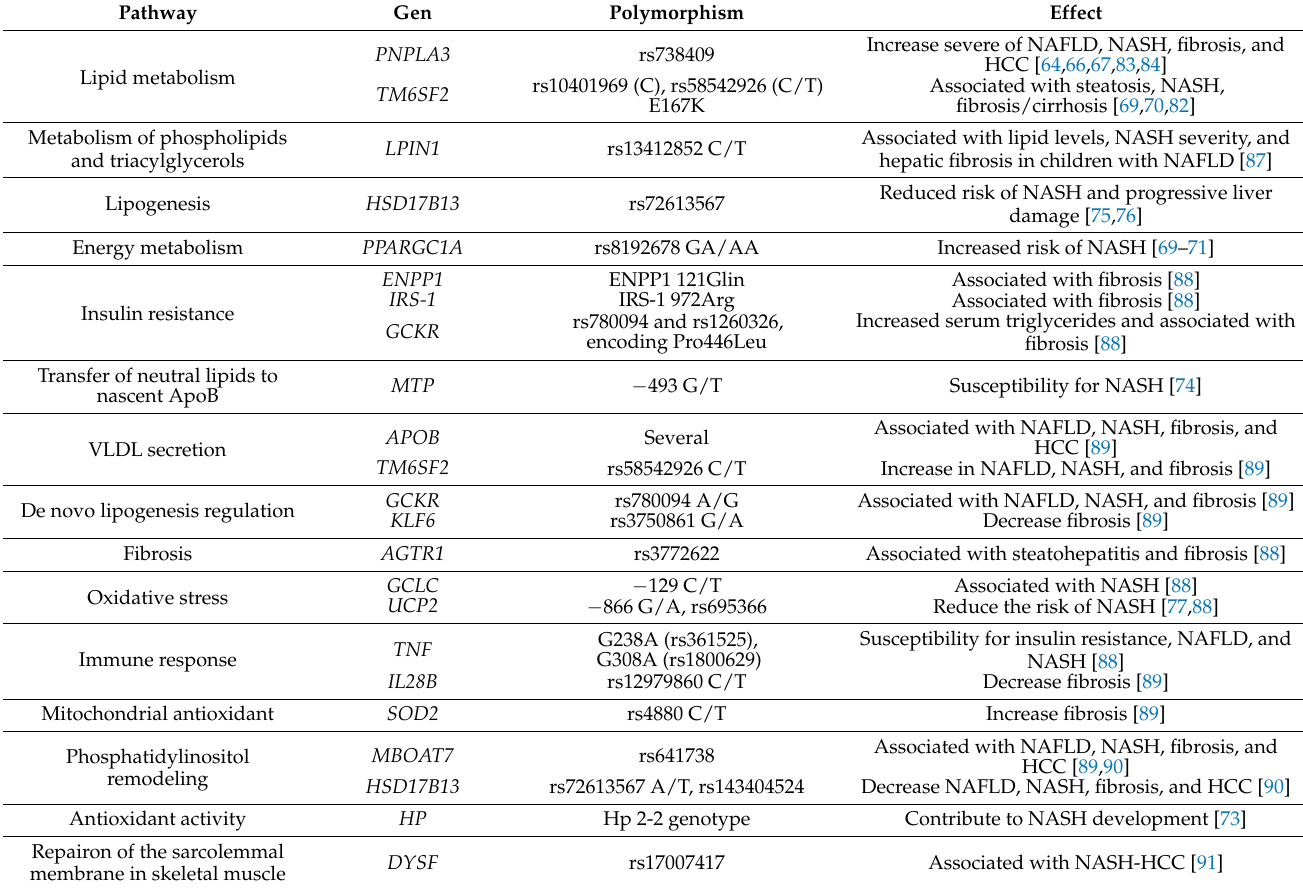
Table 1. Genetic variants (SNPs) associated with NASH and